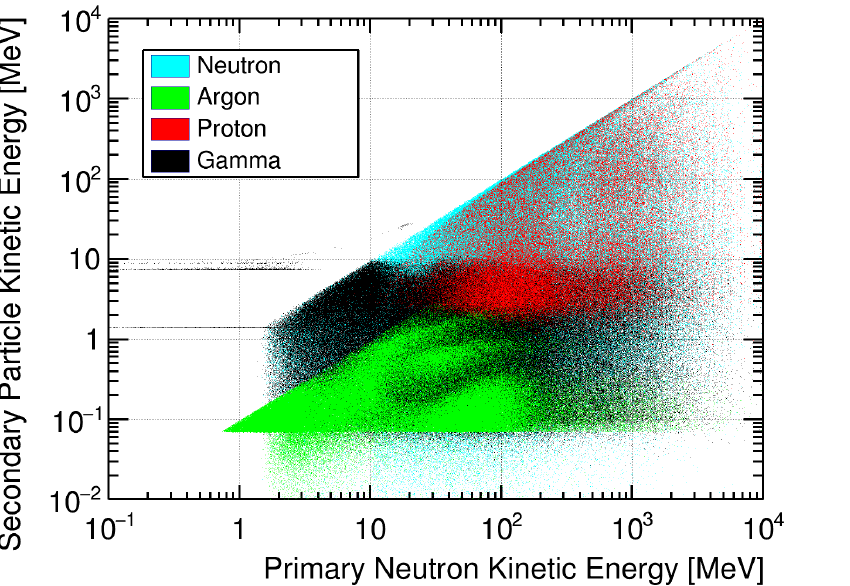
Figure 26. Kinetic-energy distribution of secondary particles with respect to incident neutron kinetic energy for neutron interactions in LAr, shown for 100,000 simulated neutrino events (which may have more than one neutron produced at the vertex).